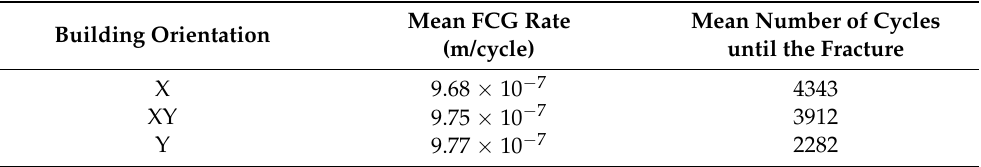
Table 5. The mean FCG rate and number of cycles of different orientations regardless of other printing